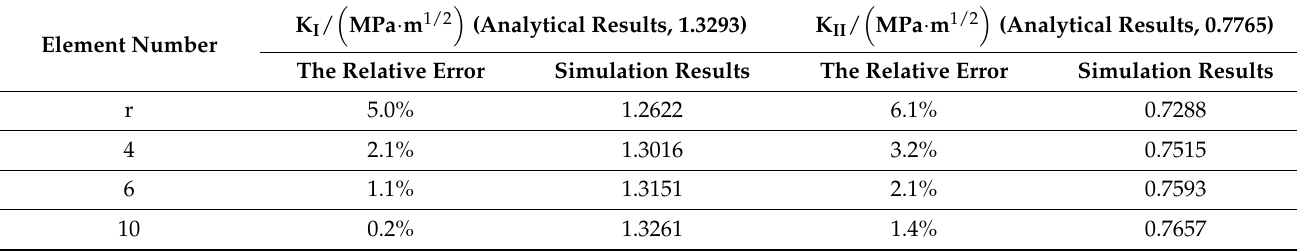
Table 1. Relative errors of I-type and II-type stress intensity factors at the crack